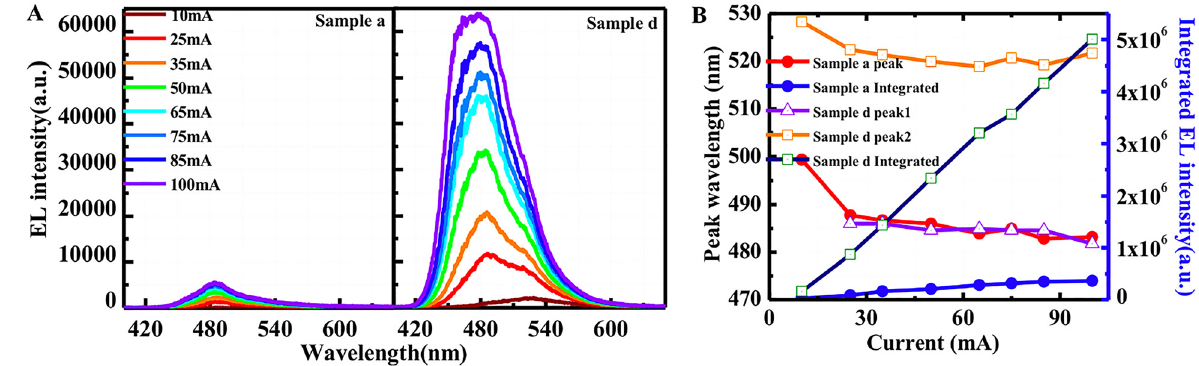
Figure 6: Comparison of EL spectra in samples a and d. (A) EL spectra of sample a and sample d measured under different current injections. (B) Peak wavelength and integrated EL intensity as a function of current